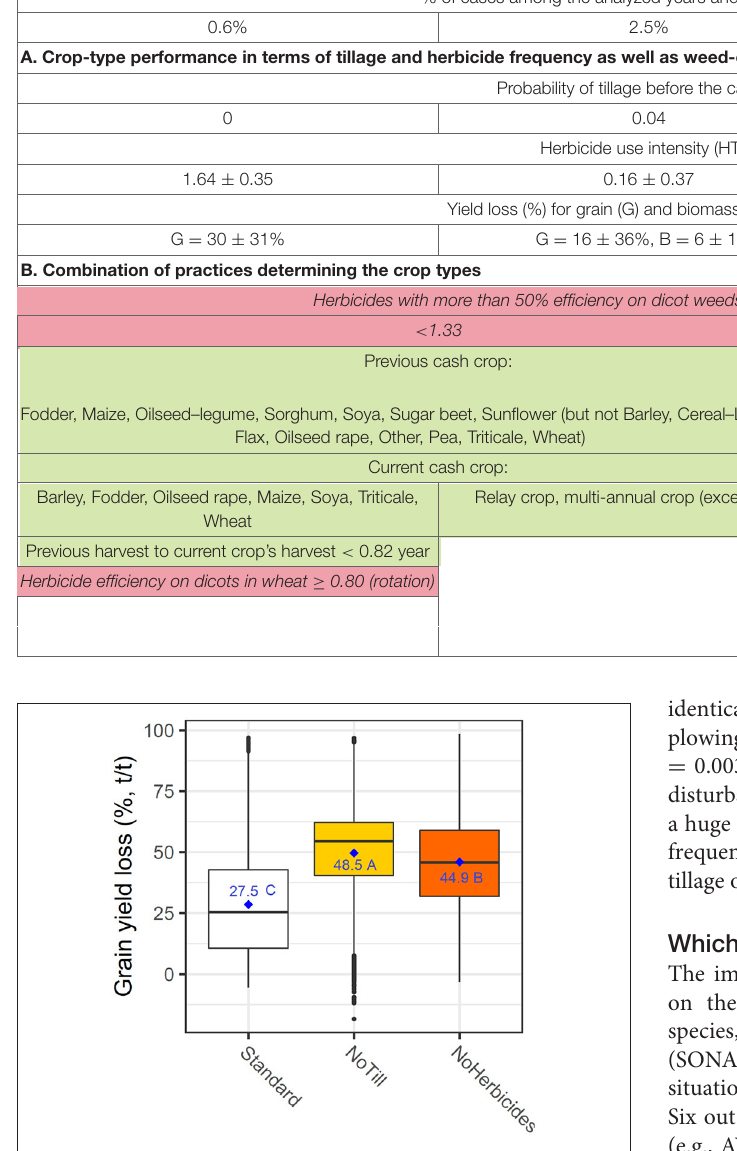
FIGURE 3 | Effect of deleting tillage or herbicides without any compensation in cropping systems on grain yield loss due to weeds, averaged over all simulated years. The analyzed data set consisted of the same 395 cropping systems × 30 years × 10 weather repetitions, simulated without modification (Standard), after deleting all tillage operations (NoTill) or after deleting all herbicide operations (NoHerbicides). Blue diamonds show means, letters indicate differences significant at p = 0.05 ( Colbach, 2022 ).